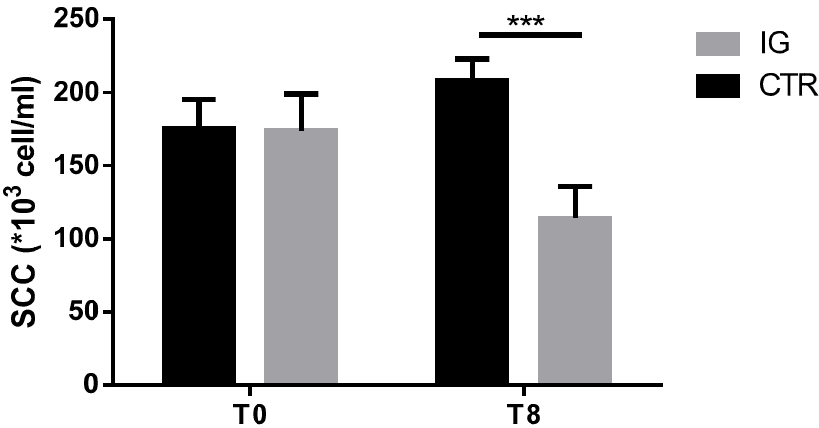
Figure 5. Somatic cell count in individual milk samples from CTR ( n = 11) and IG ( n = 11): Data are shown as mean ± SD, and differences were assessed using 2-way ANOVA. *** p -value < 0.001.